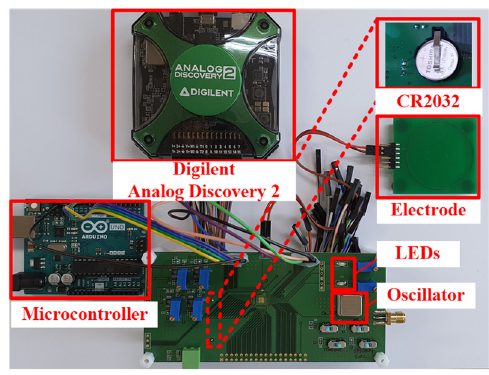
Figure 6. ( a ) Chip microphotograph; ( b ) core layout.